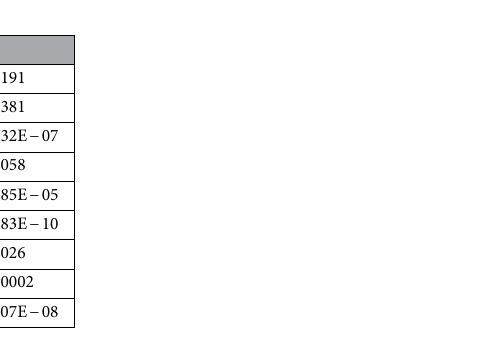
Table 4. GLMM analysis considering the region, the habitat, and their interaction on pronotum width, head area and femur area of dung beetles. d.f. : degrees of freedom.